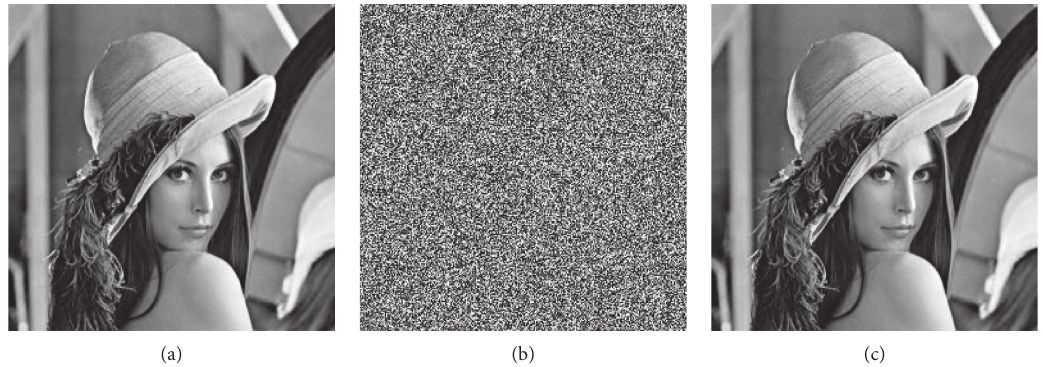
Figure 8: Simulation results. (a) Plaintext image “Lena” (256 × 256). (b) Encrypted. (c)